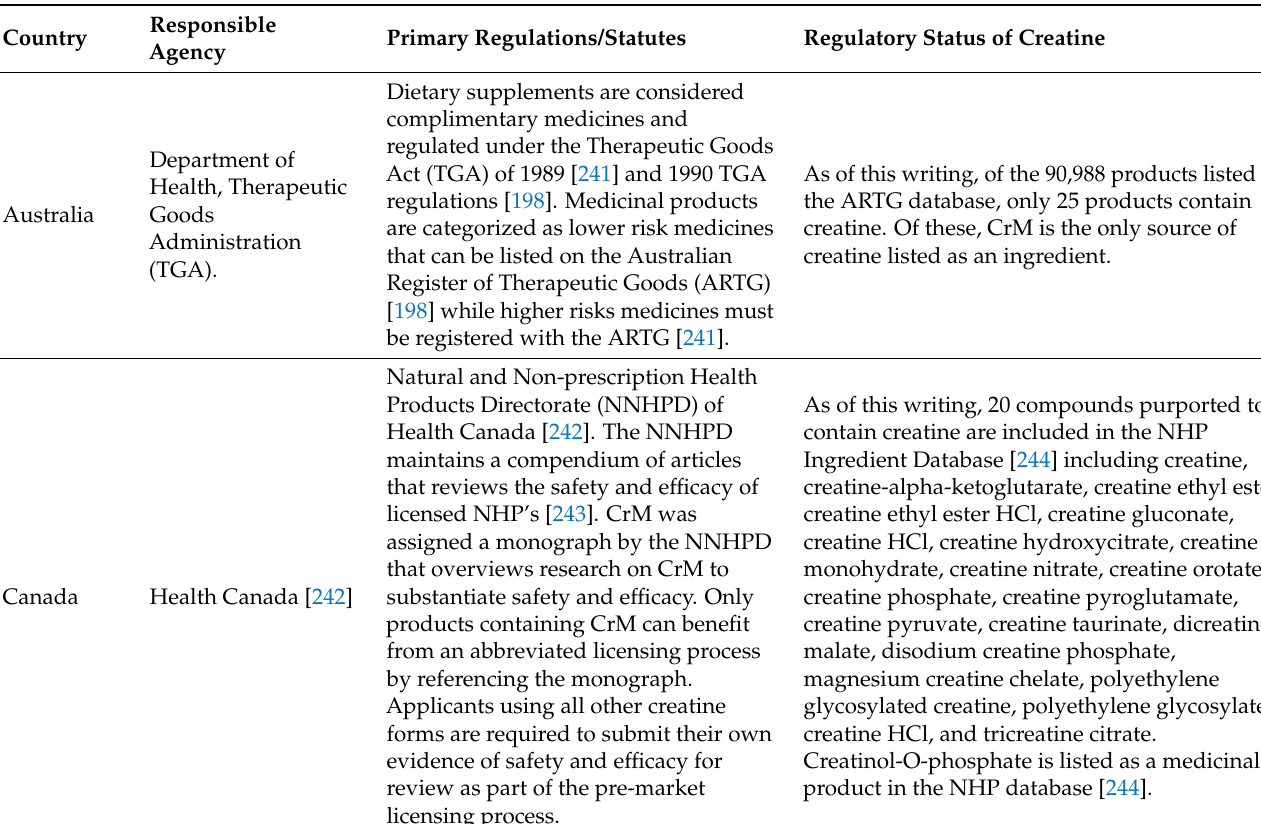
Table 6. Regulatory status of nutrients marketed as creatine supplements primary international